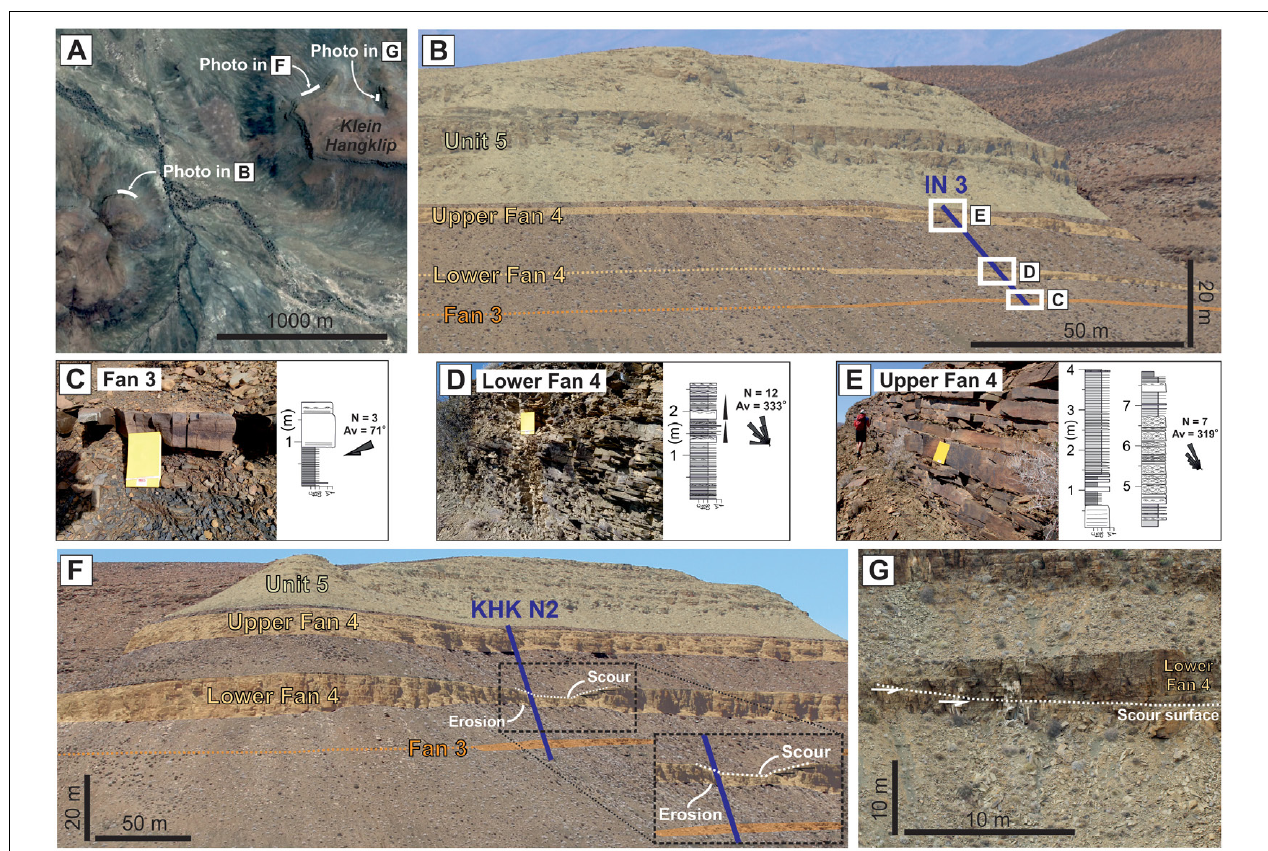
FIGURE 11 | (A) Location map of photo panels. (B) View of the western side of Klein Hangklip west showing Fan 3, lower and upper Fan 4. (C–E) Photos and sedimentary logs of Fan 3, lower and upper Fan 4 from log IN3 showing their typical appearance in this area. (F) View of the eastern side of Klein Hangklip showing Fan 3, lower and upper Fan 4. Location of log KHK N2 is indicated. (G) Photo of scour in lower Fan 4, location indicated in (A)